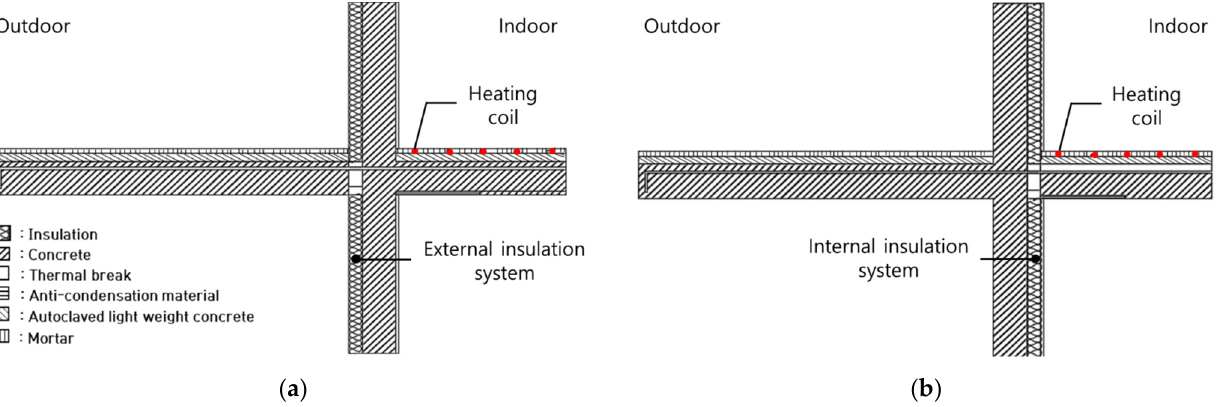
Figure 2. Section view of the balcony slab: ( a ) External insulation system; ( b ) Internal insulation system.